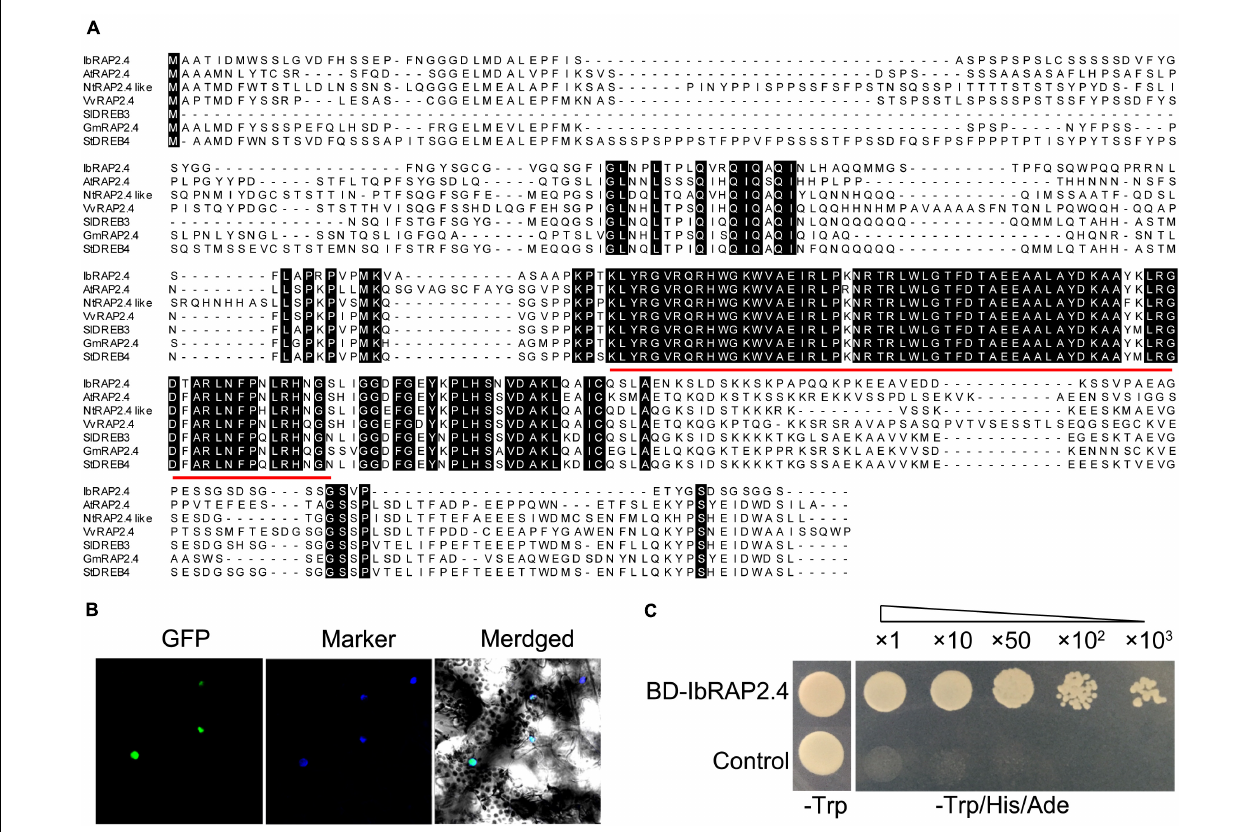
FIGURE 1 | Characterization of IbRAP2.4. (A) Amino acid sequence alignment of IbRAP2.4 and AtRAP2.4. Conserved AP2 domain is emphasized with a red line. (B) Subcellular localization of IbRAP2.4. (C) Transactivation assay of the IbRAP2.4 protein. Triangles indicate increasing dilutions ( × 1, × 10, × 50, × 100, and ×